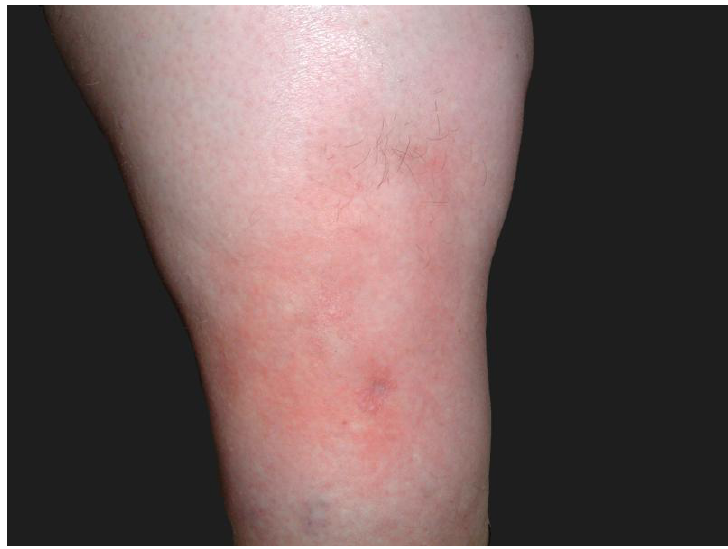
Figure. Lipodermatosclerosis on the left lower leg of a patient suffering from chronic venous